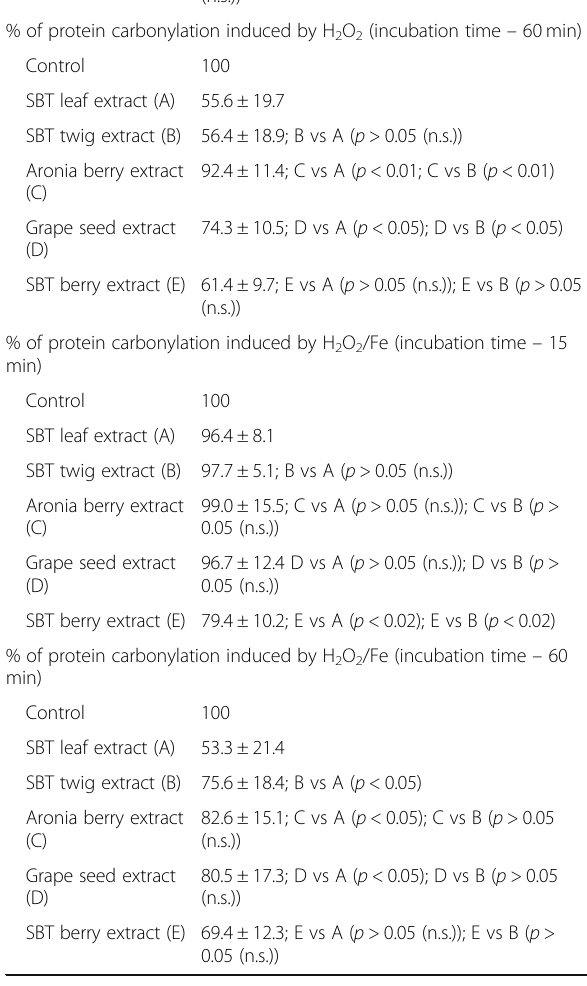
Table 2 Comparison of antioxidant properties of SBT twig and leaf extracts with properties of selected berry extracts (50 μ g/ mL; 15 and 60 min) in human plasma. Data represent means ± SD of 5 – 12. The level of marker of oxidative stress in control sample (plasma treated with H 2 O 2 or H 2 O 2 /Fe) was expressed as 100% (Continued)